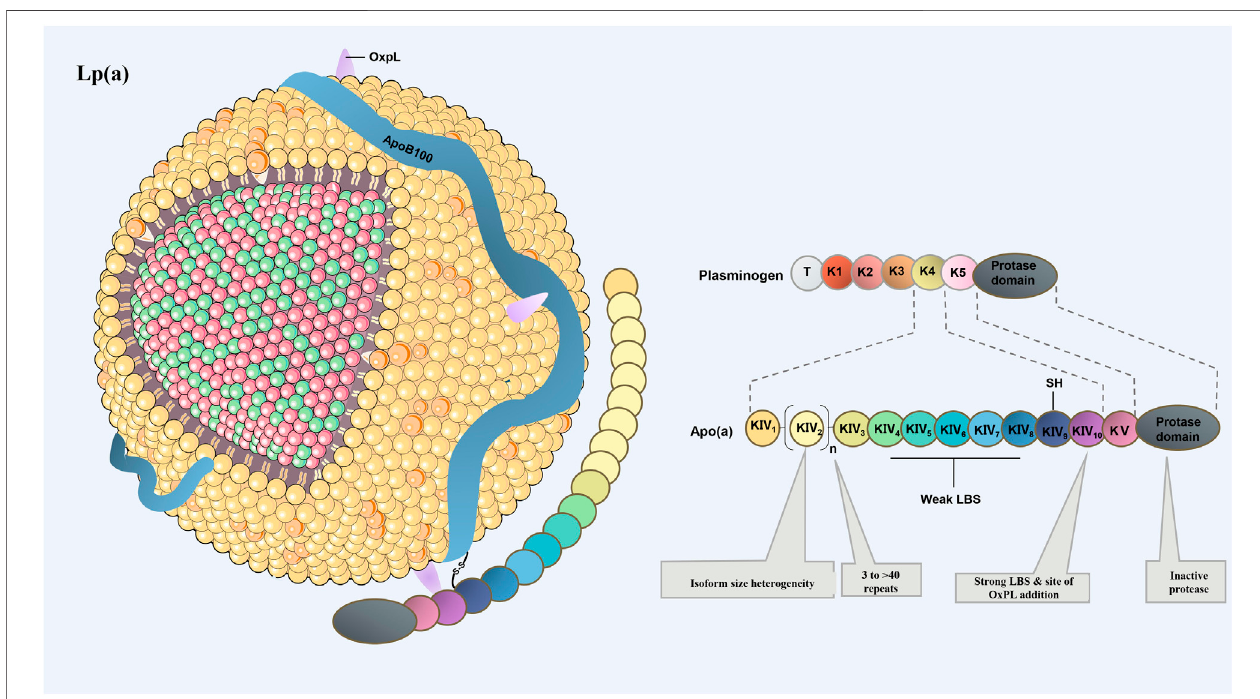
FIGURE 1 | Schematic drawing of the structure of Lp(a). Lp(a) consists of LDL-like microparticles, a single apoB100 molecule, and apo(a). Apo(a) is composed of inactiveproteasePdomainandcyclicdomain.HeterogeneityinthenumberofK Ⅳ type2repeatsaccountsfordifferentapo(a)isoforms.ExceptK Ⅳ 2 ,whichhasmultiple copies, the remaining domains are single copy. K Ⅴ , kringle ring structure Ⅴ ; K Ⅳ , kringle ring structure IV.